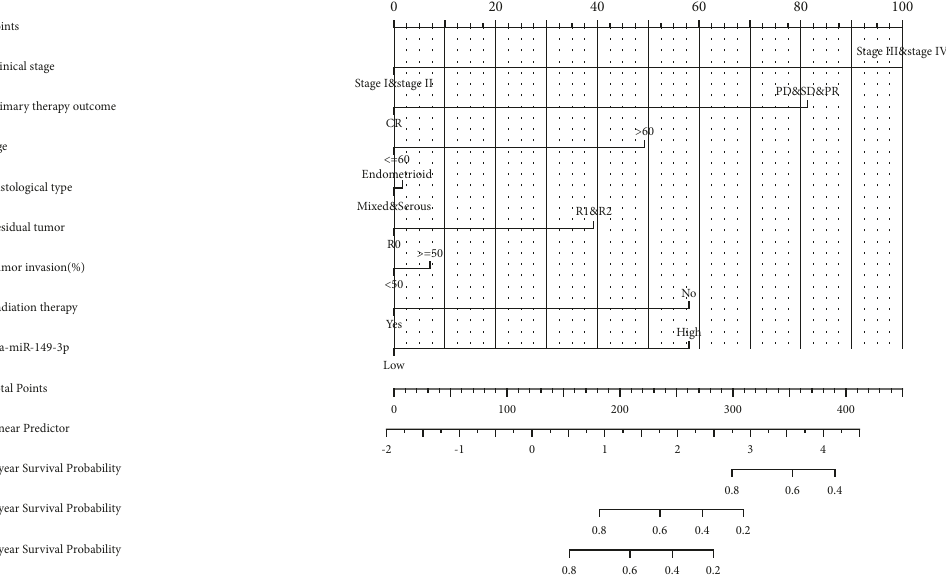
Figure 5: Nomogram predicts 1-, 3-, and 5-year overall survival in patients with